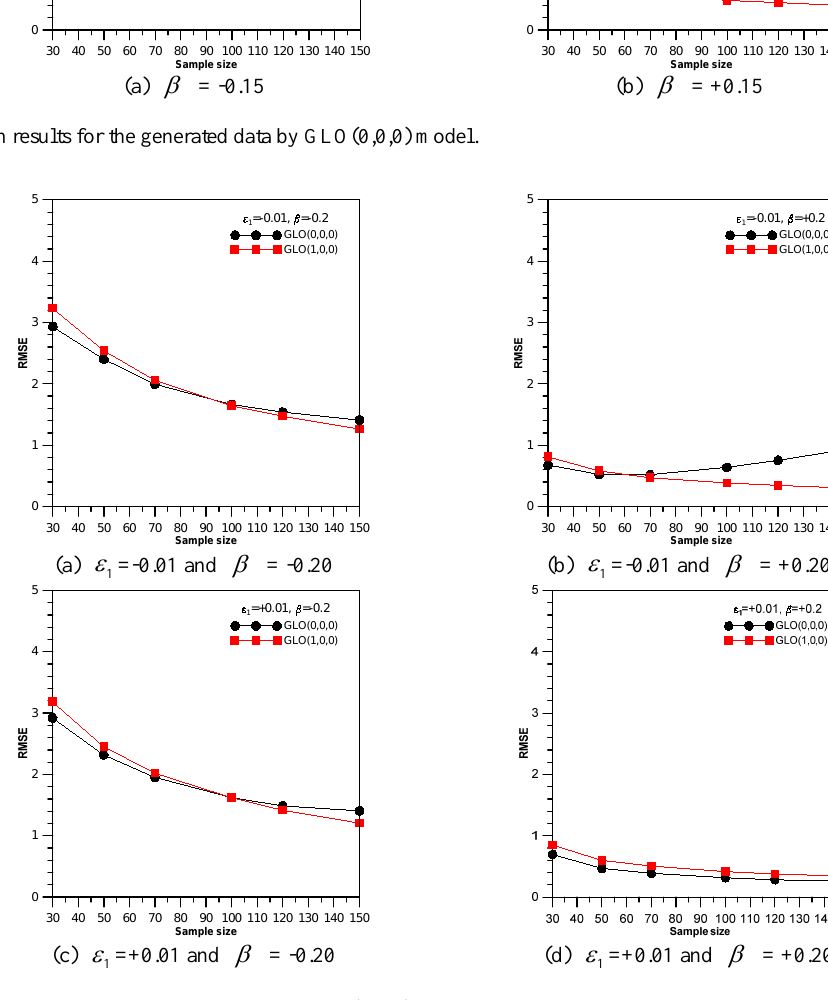
Figure 2. Simulation results for the generated data by GLO(1,0,0) model.